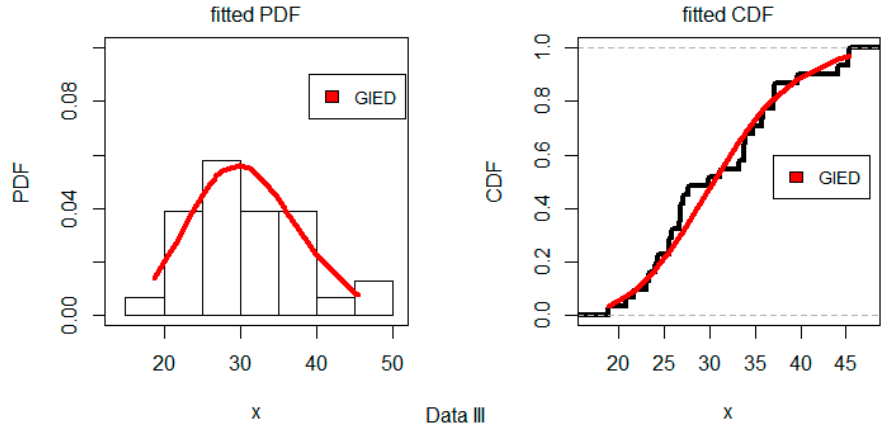
Figure 8. Estimated PDF and CDF plots using Data III for the GIED.